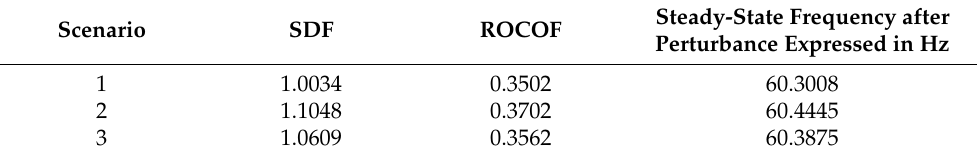
Table 1. Stability metrics.